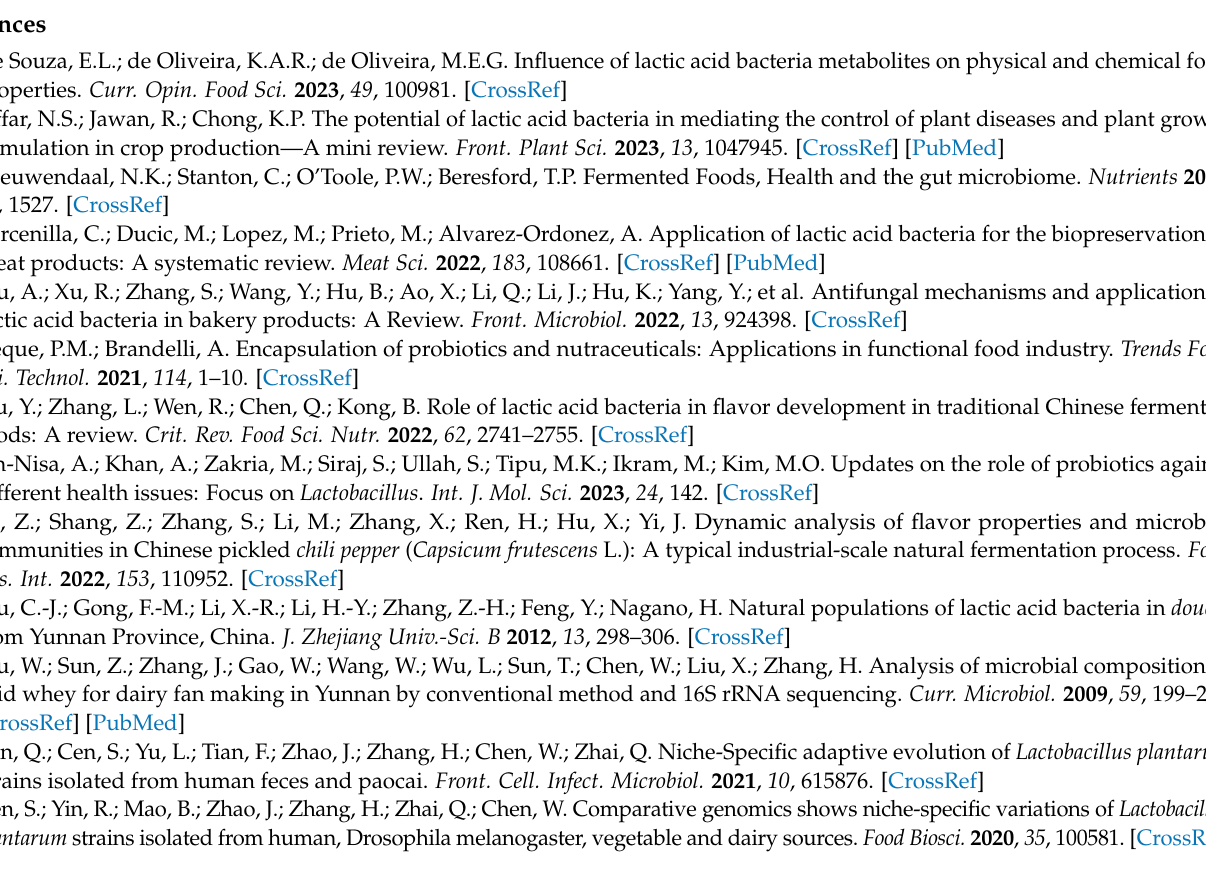
Figure S2: GC content and genomic size of Lactobacillus plantarum . (A) GC content distribution of L. plantarum . (B) Genomic size distribution of L. plantarum ; Table S1: Detailed information of 54 strains of Lactobacillus plantarum